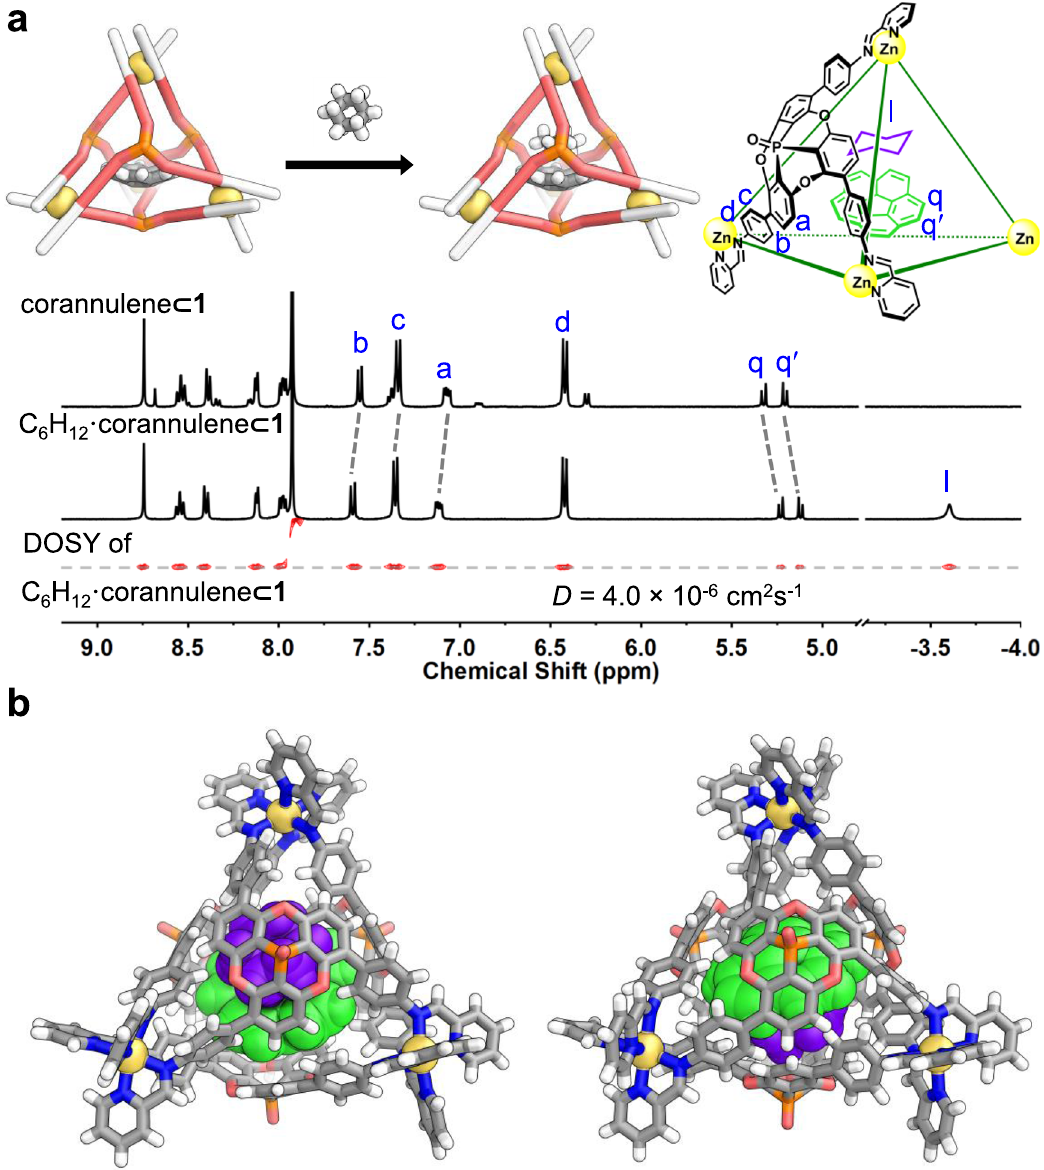
Fig. 3 Ternary complex formation. a Scheme of the binding of corannulene and cyclohexane within 1 , and comparison of the 1 H NMR spectra (CD 3 CN, 400 MHz, 298 K) of corannulene ⊂ 1 and C 6 H 12 • corannulene ⊂ 1 , together with the 1 H DOSY spectrum of C 6 H 12 • corannulene ⊂ 1 . b Two views of the cationic part of the crystal structure of C 6 H 12 • corannulene ⊂ 1 , showing cyclohexane in purple and corannulene in